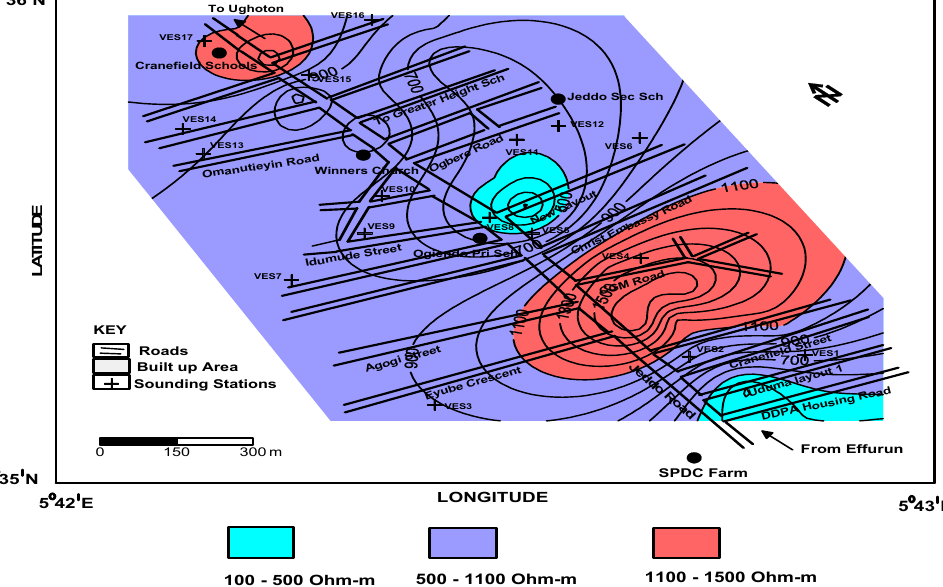
Figure 8. Map of aquifer resistivity.